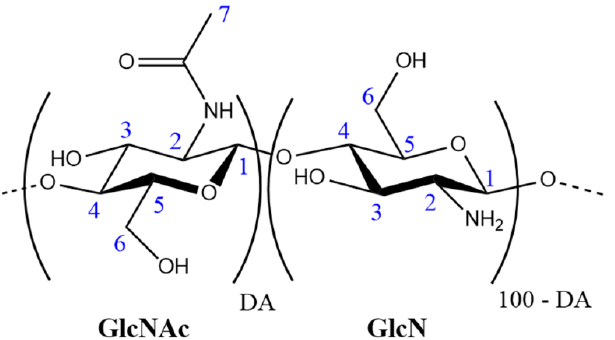
Figure 1. Chitin and chitosan structures showing the acetylated (GlcNAc) and deacetylated (GlcN) units. DA represents the degree of N-acetylation, for chitin DA = 100.